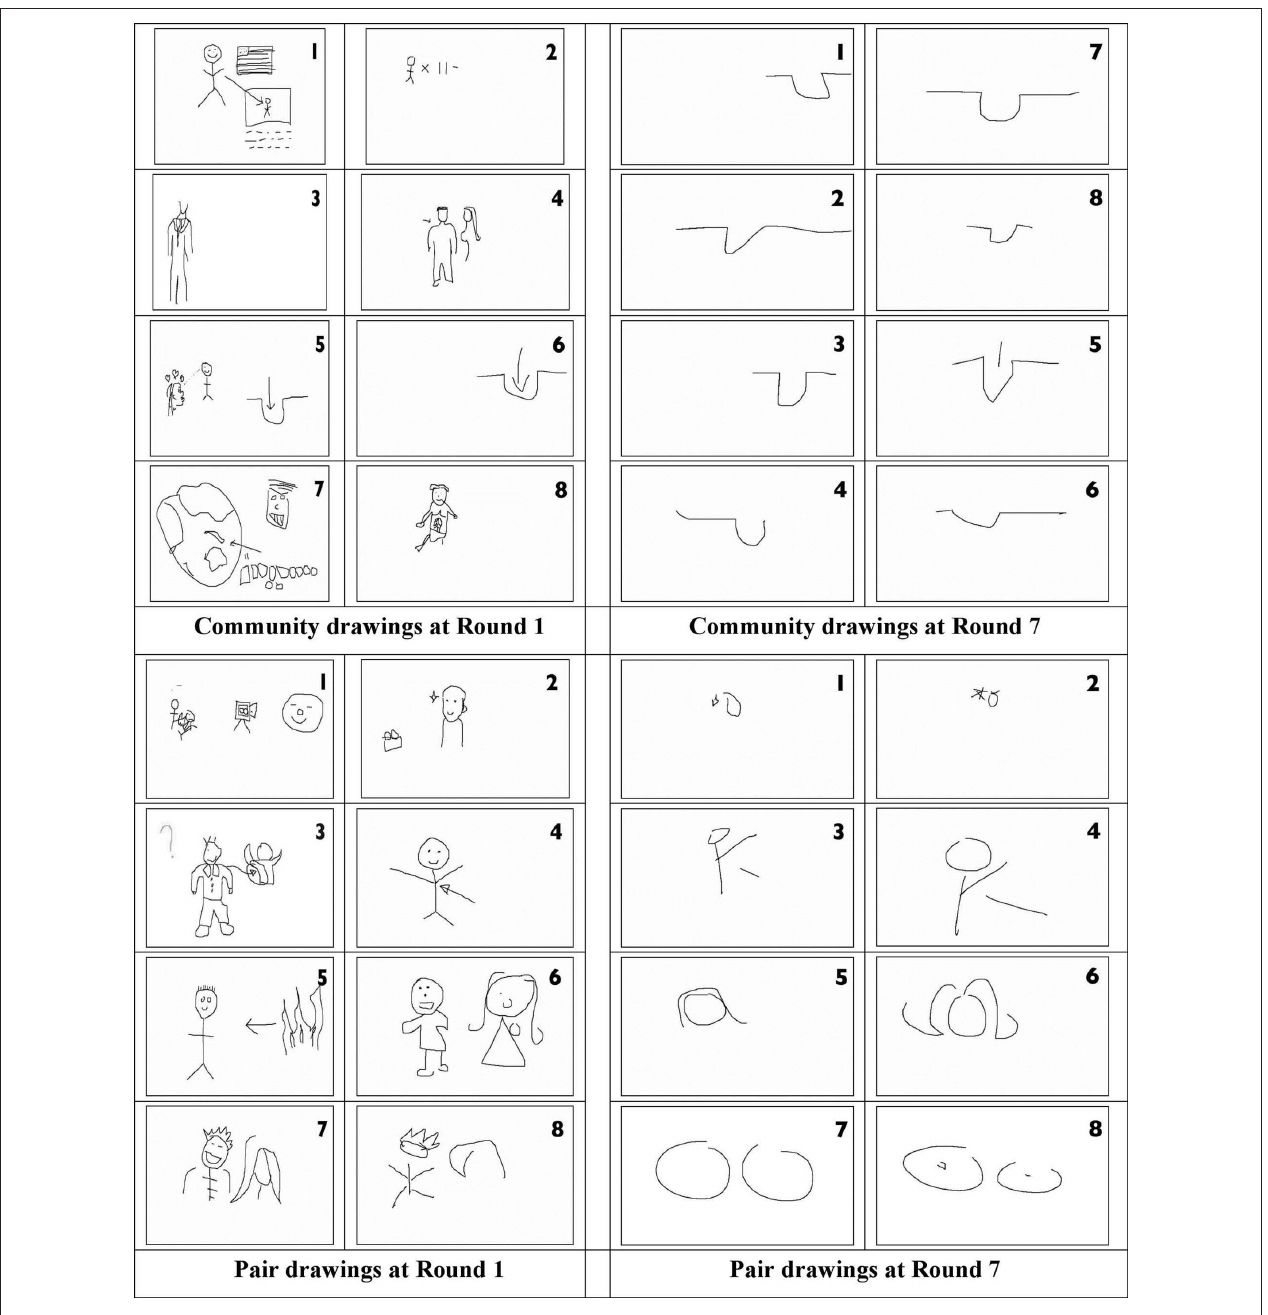
Figure 9 | Drawing refinement and convergence for the concept “Brad Pitt” among a Community of interlocutors and between isolated Pairs at round 1 and round 7. Participant numbers are given in bold at the top right of each drawing. (From Fay et al., 2010).